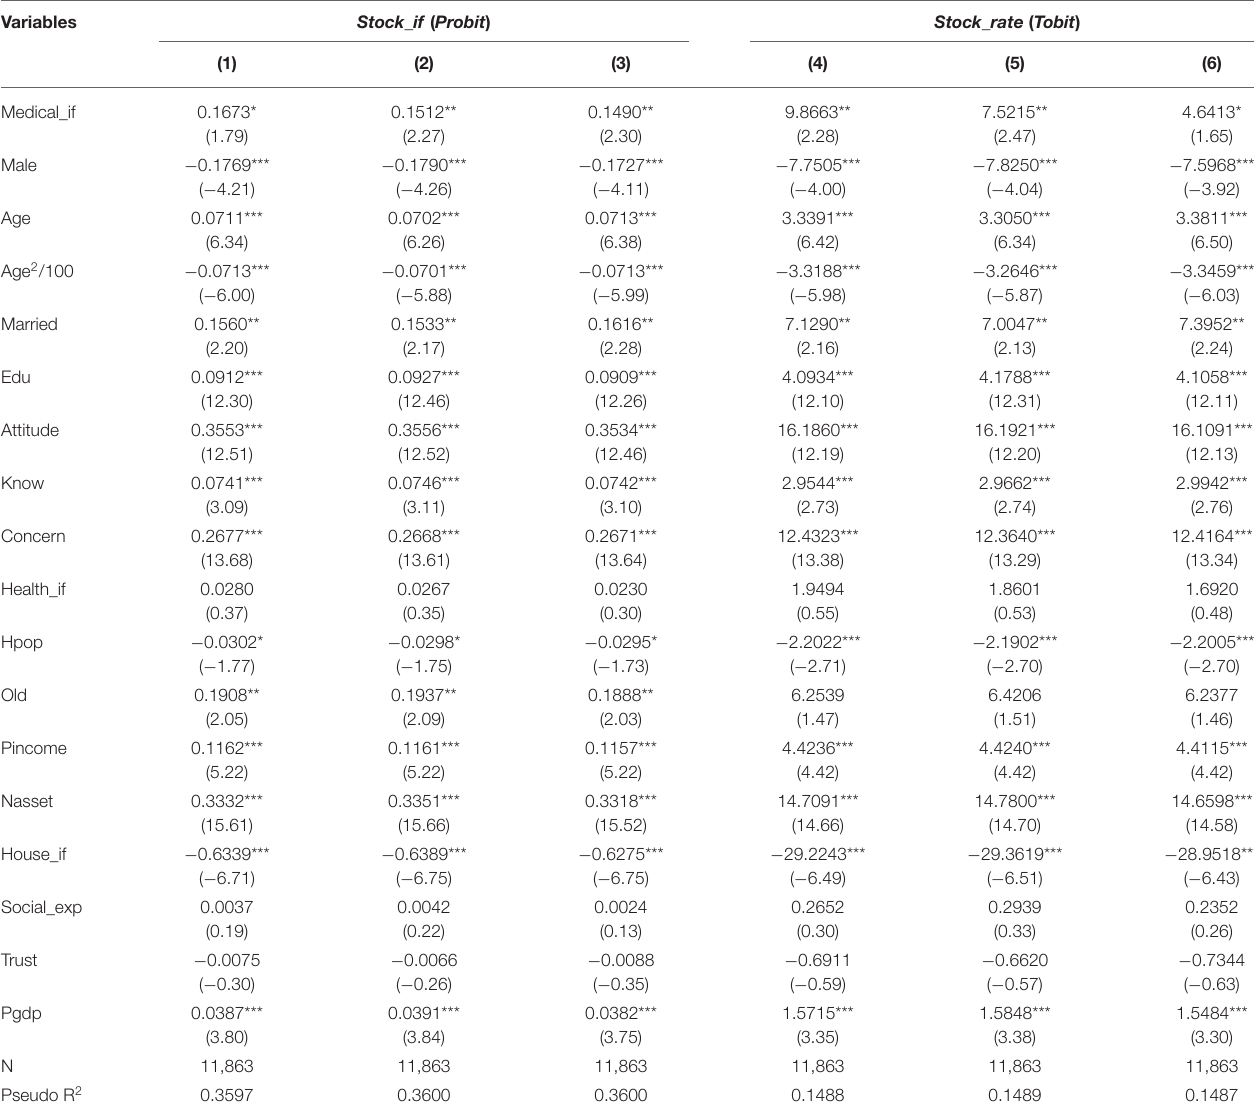
TABLE 4 | Benchmark regression